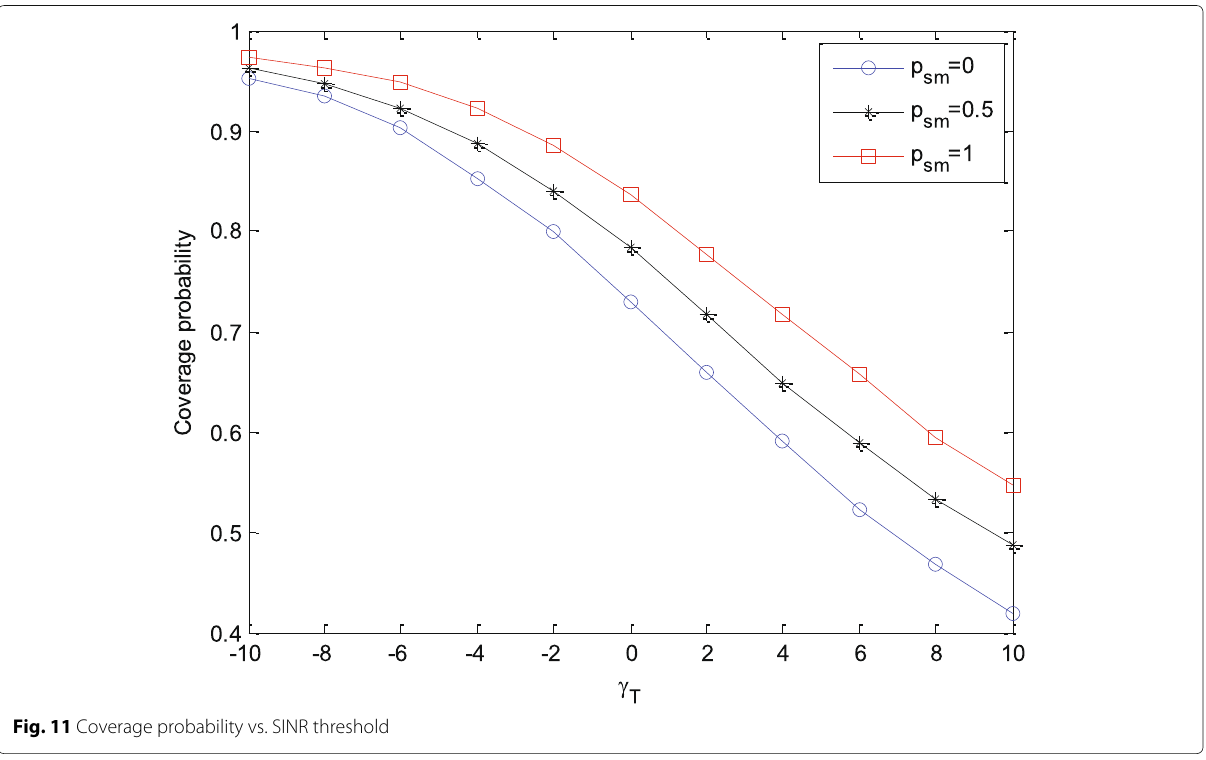
Fig. 11 Coverage probability vs. SINR threshold